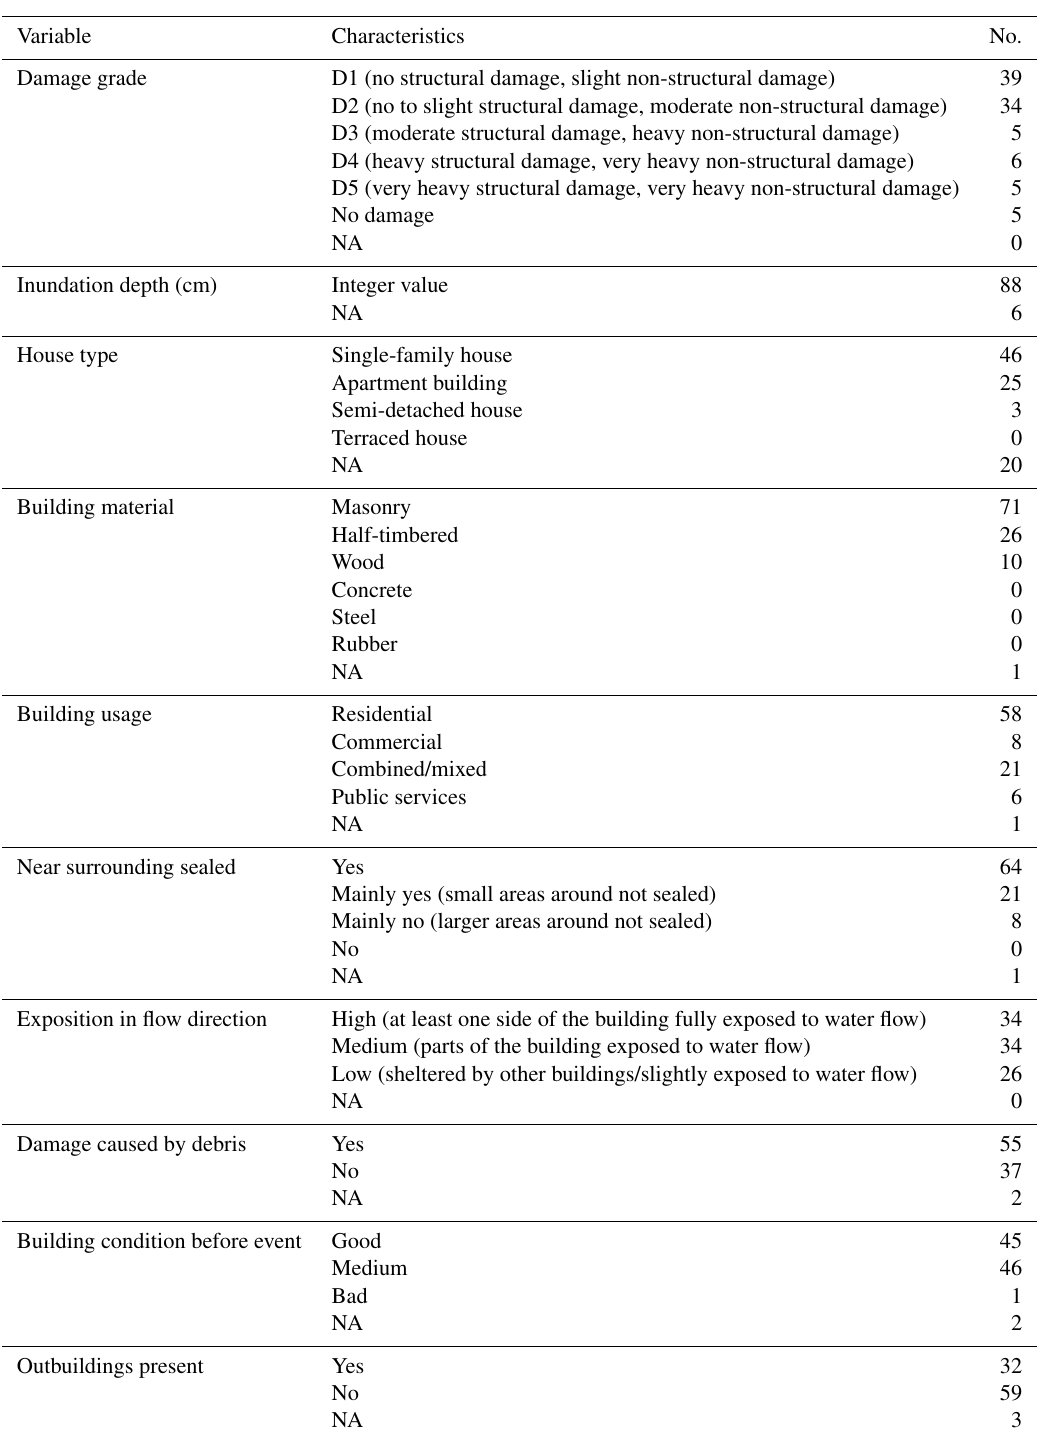
Table 2. Features of 94 buildings affected by flooding in Braunsbach, Germany, recorded between 7 and 8 June 2016, and their frequency of